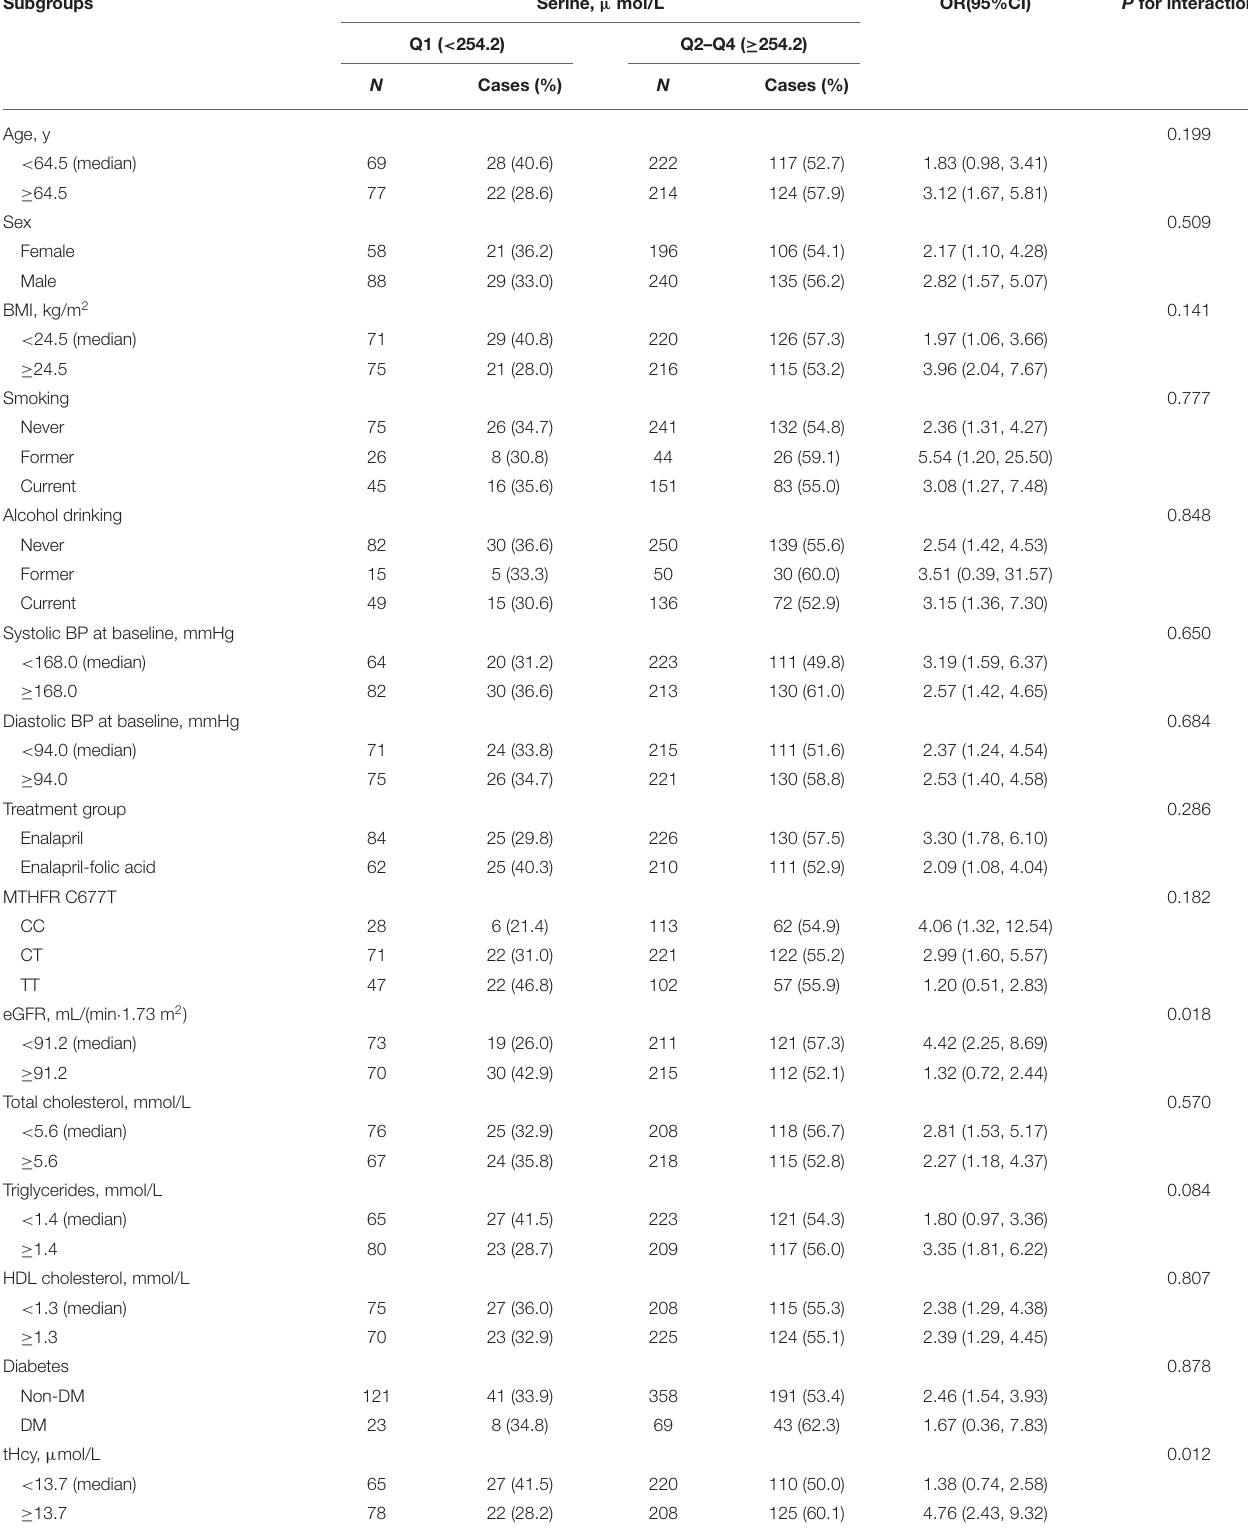
TABLE 3 | The association between serum serine and the risk of all-cause mortality in various subgroups.